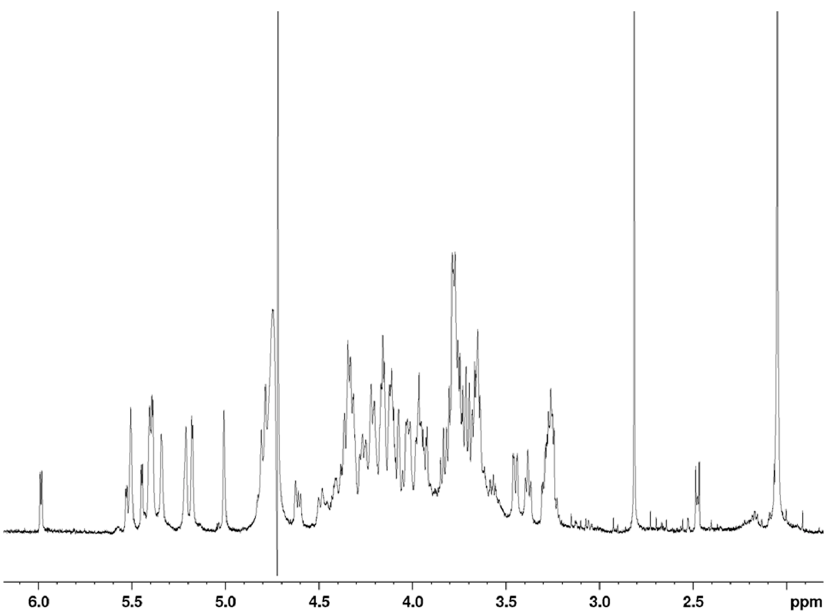
Table 4. Proton and carbon chemical shifts of the two pentasaccharide sequences identified inside